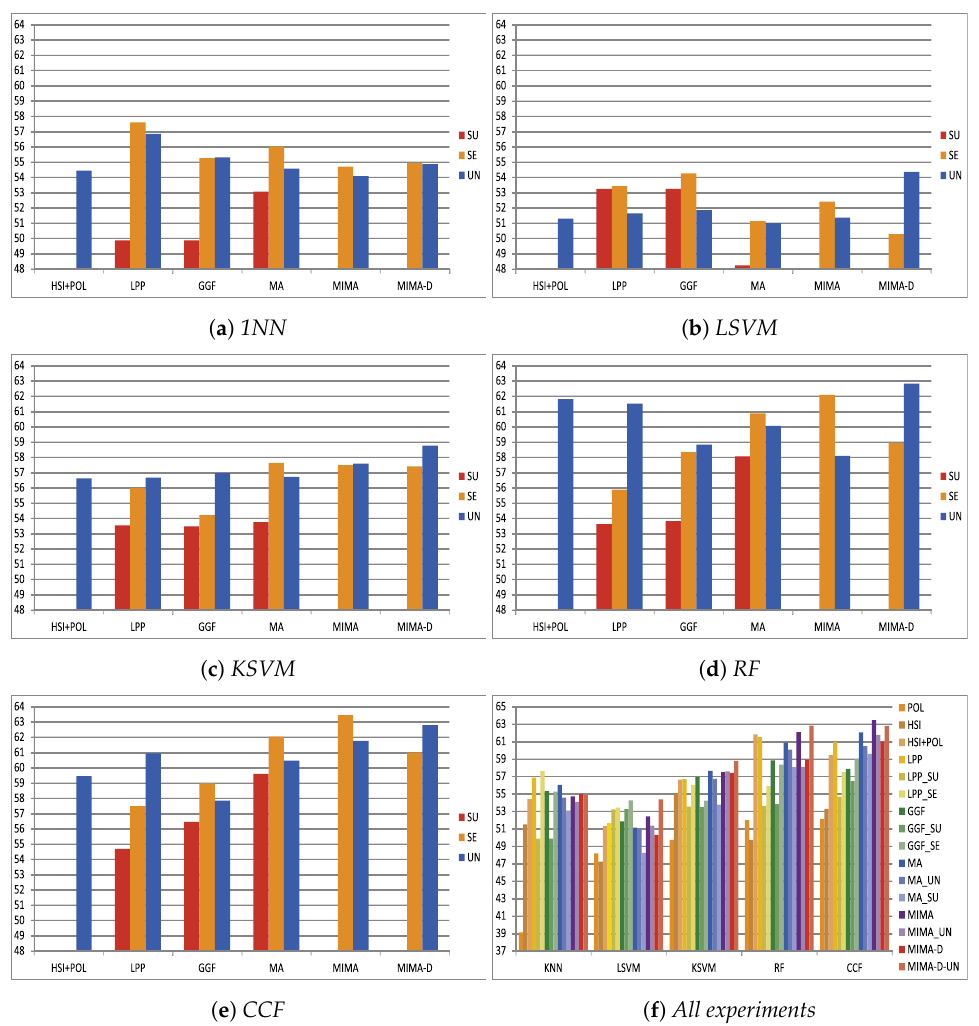
Figure 6. Comparison of the classification accuracies of different classifiers applying on the Augsburg data set. Each chart is resulted from a corresponding classifier. The right bottom chart demonstrates all the overall accuracy resulted by applying five classifiers on the fused data achieved from each of the 16 algorithms. The y -axis is the overall accuracy in percentage (%). The ’SU’, ’SE’, and ’UN’, represent supervision, semi-supervision, and un-supervision,